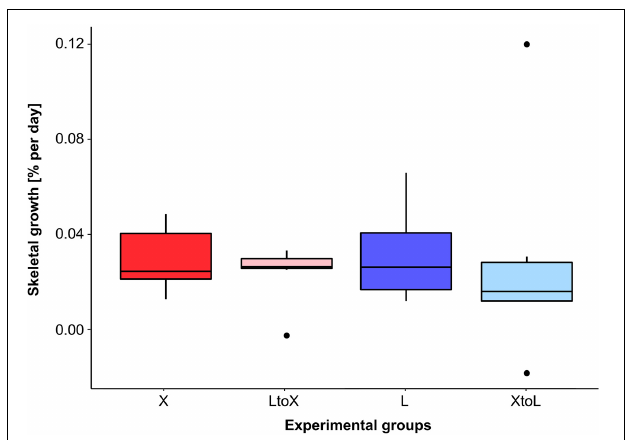
FIGURE 3 | Skeletal growth rates [% d − 1 ] of T. endesa specimens from four experimental groups. Growth rates of control corals from the central region of Comau Fjord at XHuinay (X; red) and of corals transplanted from Lilihuapi to XHuinay (L to X, light red), as well as the control corals at the mouth of the fjord at Lilihuapi (L, blue) and of corals transplanted from XHuinay to Lilihuapi (X to L; light